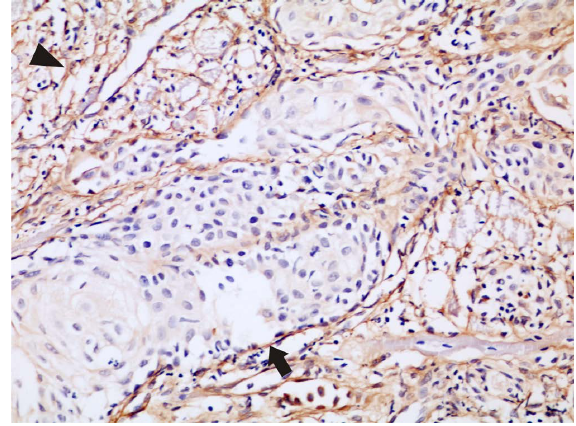
Figure 2. Immunoexpression of fibronectin in SCCLi throughout peritumoral basement membrane (arrow) and tumor stroma (arrowhead) (LSAB method, original magnification ×400).